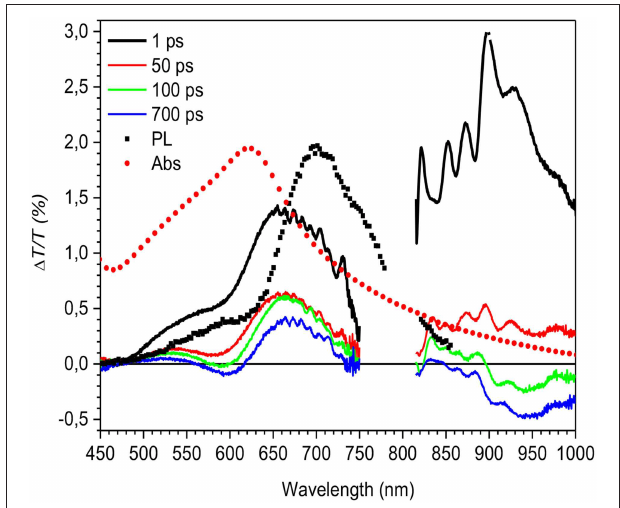
FIGURE 7 | Normalized decay traces at different wavelengths (see legend in the figure) for the LMM mesoparticle